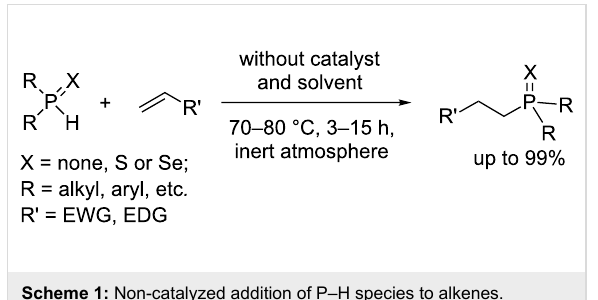
Table 1: The substrate scope for the aerobic addition of phosphine oxides 1a–f to vinyl sulfides 2a–c . a